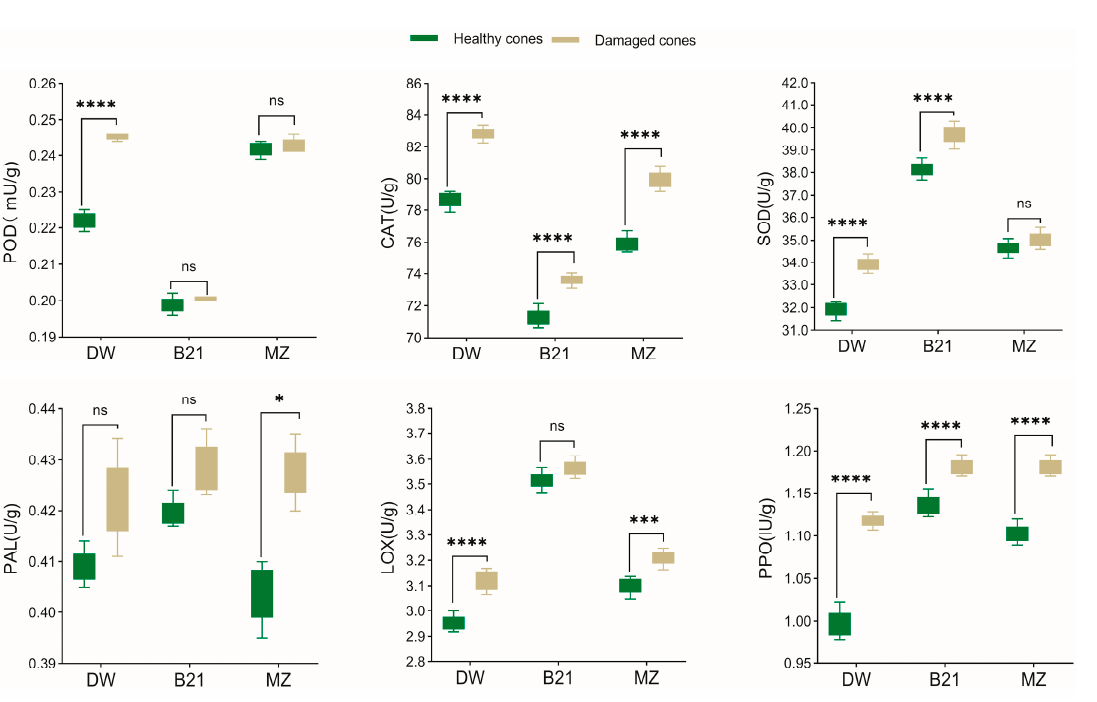
Note: Different lower letters represent the significant difference among hazelnut cultivars at the level of p < 0.05. The ABA and JA contents in the shells of three cultivars were significantly increased after C. nucum chewing. Additionally, SA contents of MZ and B21 shells significantly increased after C. nucum chewing (Table 5, Figure 3).